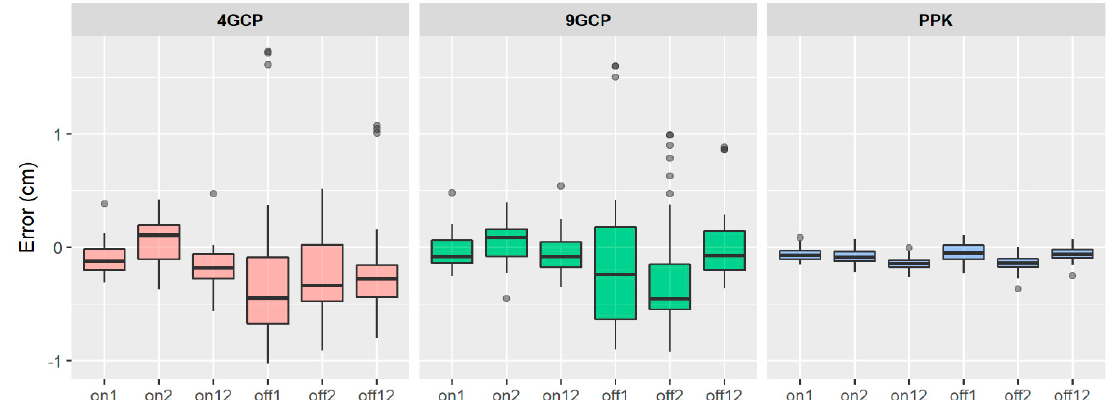
Figure 7. Boxplots represent horizontal errors separated by georeferencing method and divided by the seasons and flight patterns (horizontal line represents median, the lower part of hinge represents the 25th percentile and upper part represent 75th percentile, whiskers represents 1.5 × IQR (interquality range) in both directions) acquired on orthomosaics.